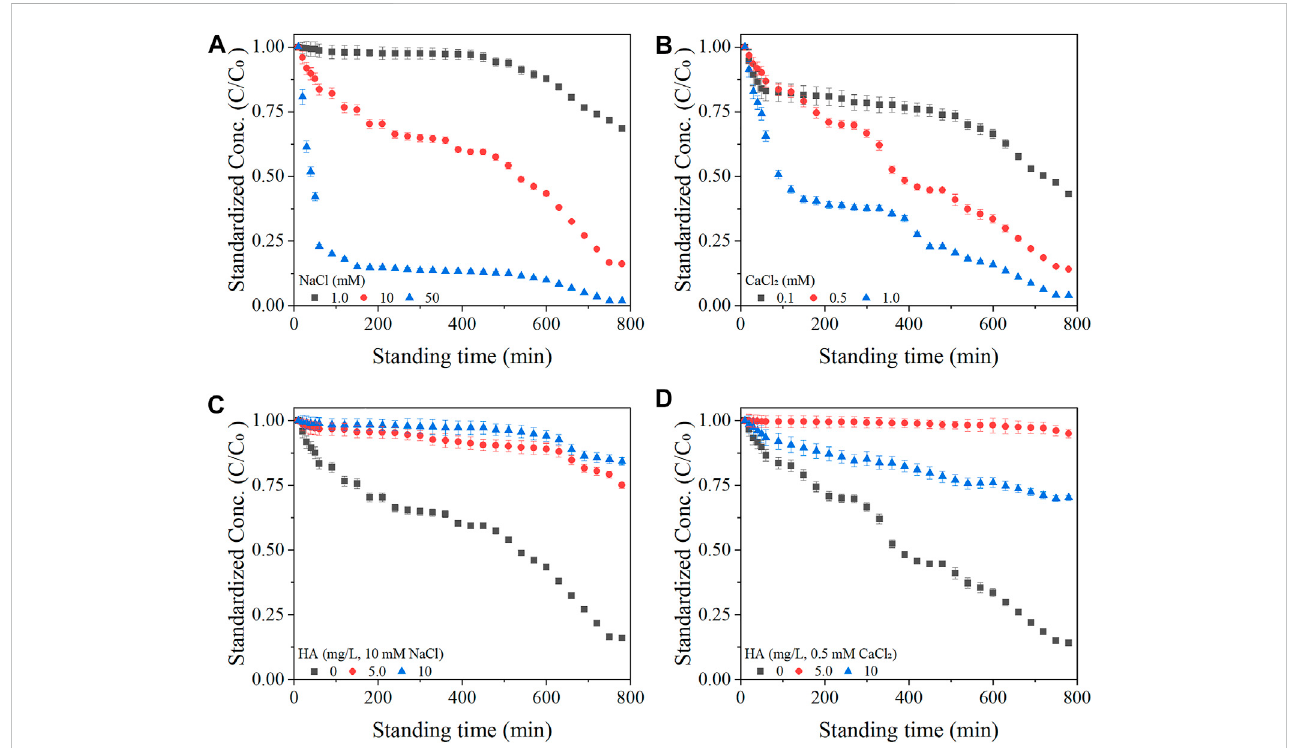
FIGURE 1 Colloidal stability of biochar nanoparticles (BC-NP) (expressed as standardized concentration of C/C 0 , C and C 0 are the real-time and initial concentration of in fl ux respectively) atvarying concentrations of NaCl [1.0, 10, and 50 mM; (A) ], CaCl 2 [0.1, 0.5, and 1.0 mM; (B) ], and HA (0, 5.0, and 10 mg/L) in the presence of 10 mM NaCl (C) or 0.5 mM CaCl 2 (D) . Error bars represent the standard deviation of means ( n =